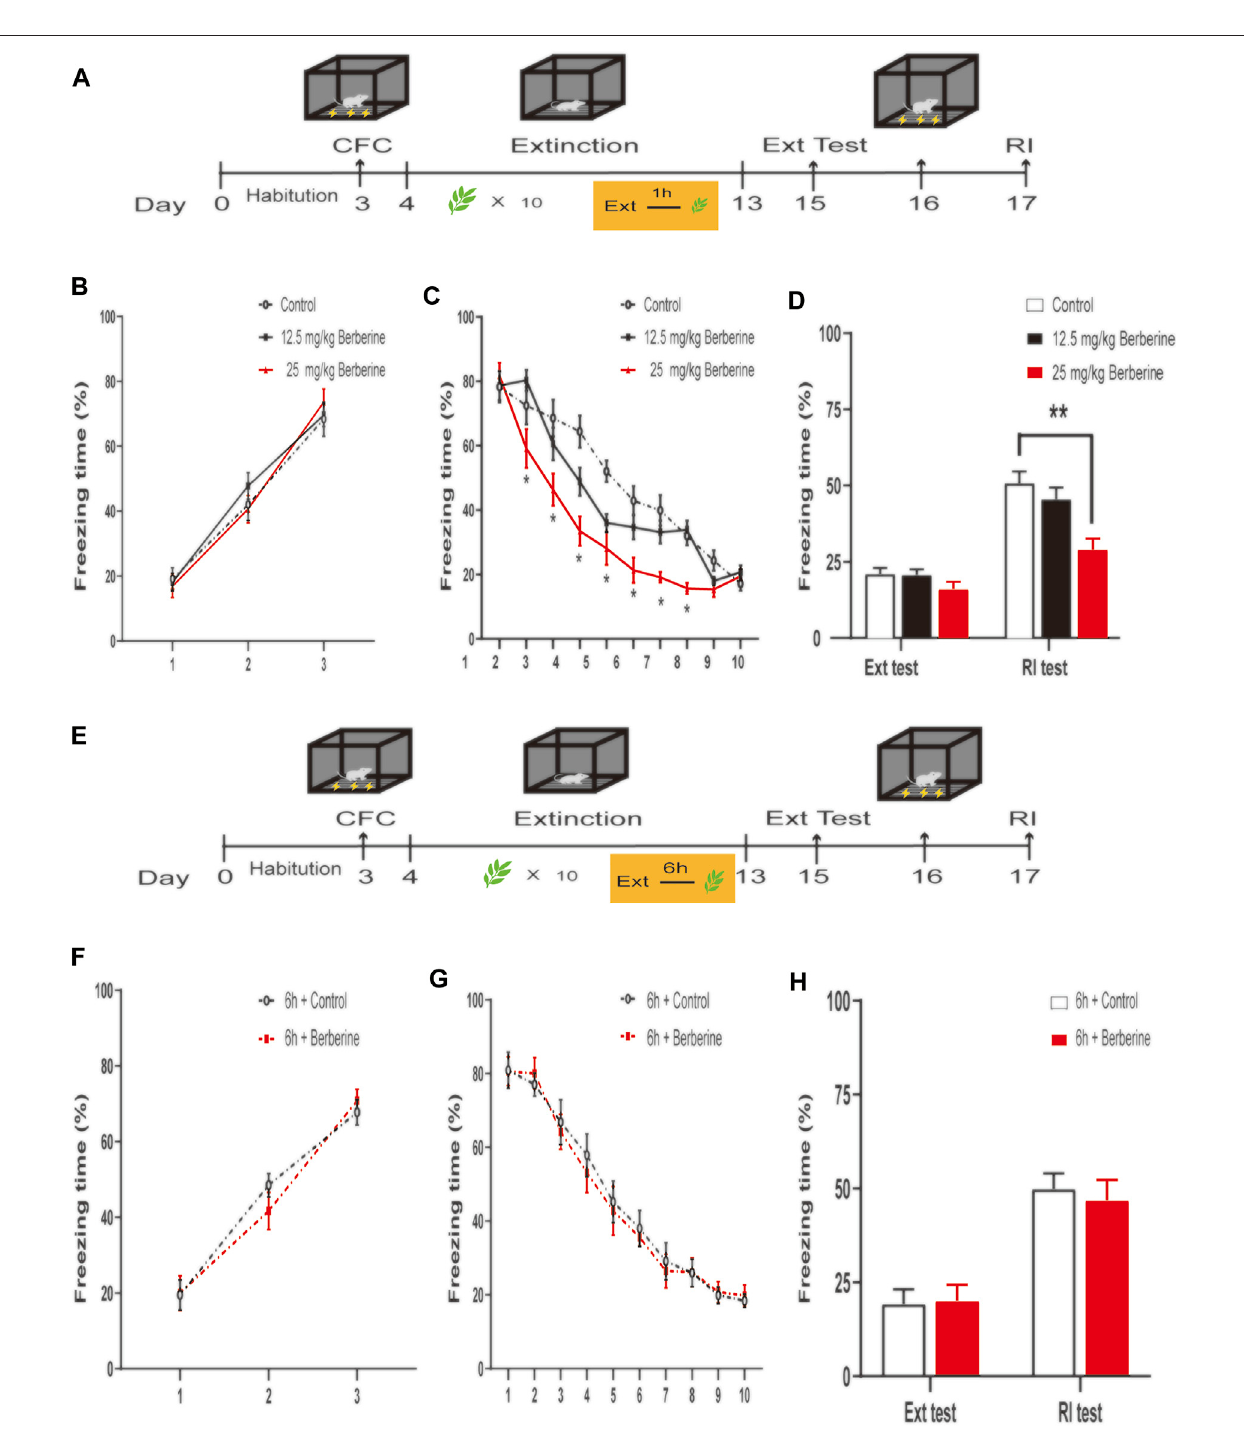
FIGURE 1 | Berberine administration 1 h after extinction enhanced extinction and reduced reinstatement of recent fear. (A, E) Timeline of contextual fear conditioning, drug treatment, extinction training, extinction test, and reinstatement test. (A) One hour after each extinction training session, corn oil (1 ml/kg, intragastrically [i.g.]) or berberine (12.5 and 25 mg/kg, i.g.) was administered to mice, respectively. (E) Six hours after each extinction training session, 1 ml/kg corn oil (i.g.) or 25 mg/kg berberine (i.g.) was administered to mice. (B, F) Freezing levels during fear conditioning were similar between different groups. (C, G) Freezing behaviors declined during extinction training sessions. (C) Repeated-measures ANOVA, effect ofthe training day, F (9,189) = 164.1, p 0.001; Bonferroni post hoc test, p < 0.05, during theextinction training days2 – 8. (D, H) Percentage offreezingtime during extinction test(left) andreinstatement test (right). (D) Signi fi cantfreezingtime was observedinRItest, p < 0.01. n =7 – 8micepergroup.Dataaremeans±SEM,* p < 0.05,** p < 0.01,comparedwiththecontrolgroup.CFC,contextualfearconditioning; Ext, extinction; RI, reinstatement.